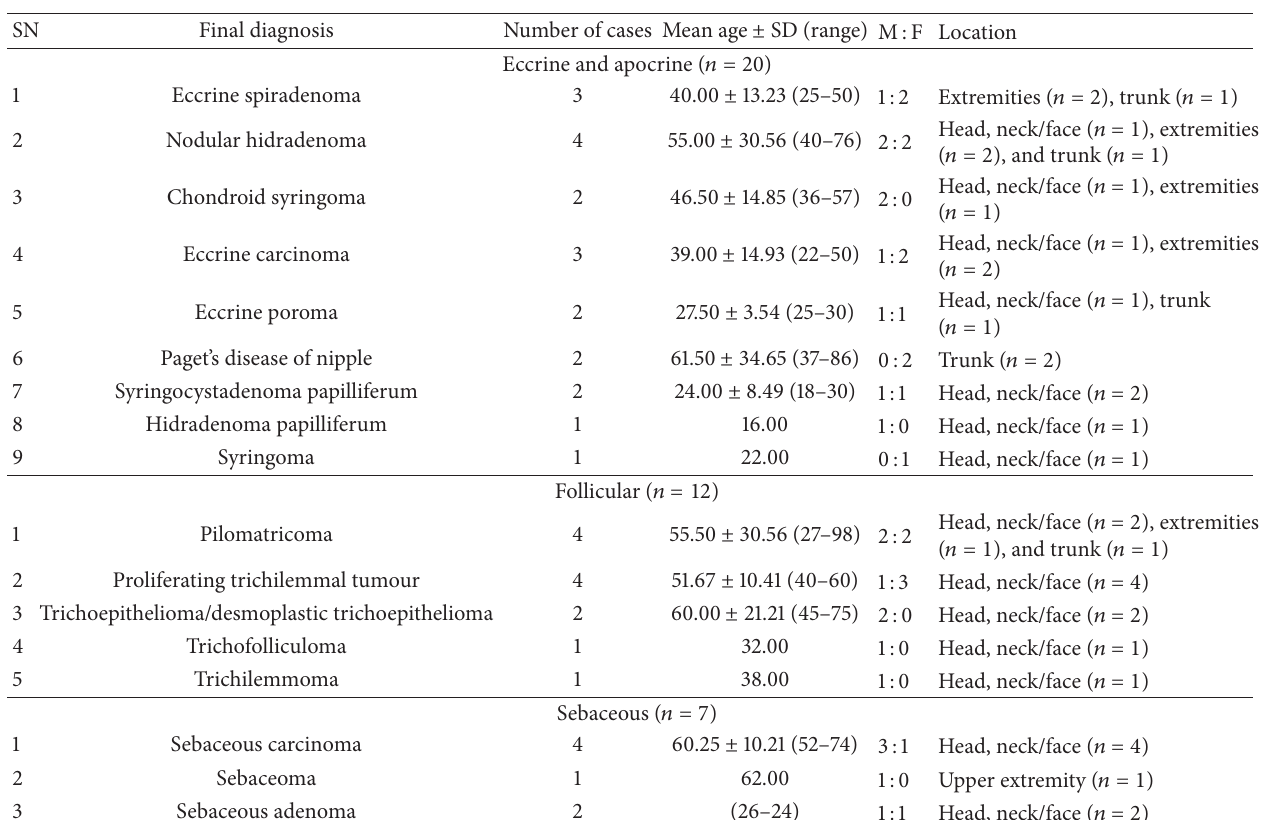
Table 5: Clinical profile of different adnexal